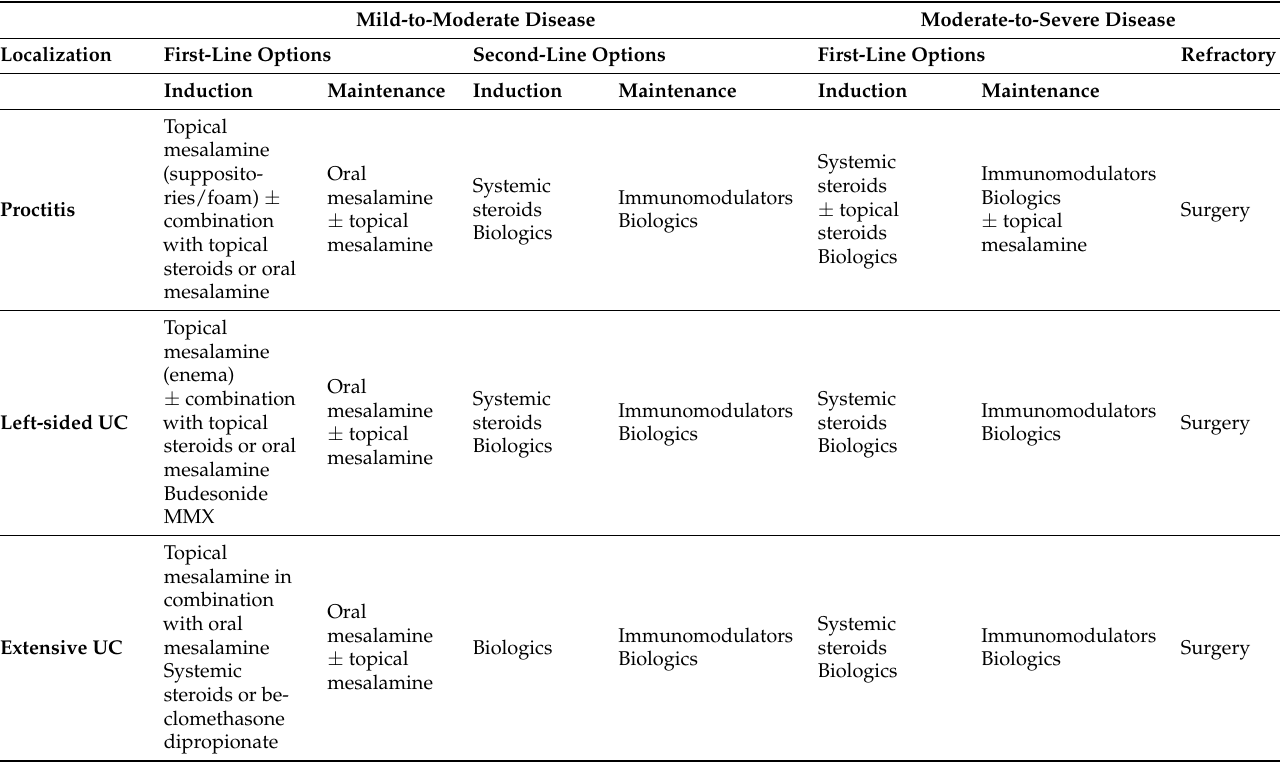
Table 1. Recommended first and second-line options in the management of Ulcerative Colitis (UC) according to localization of